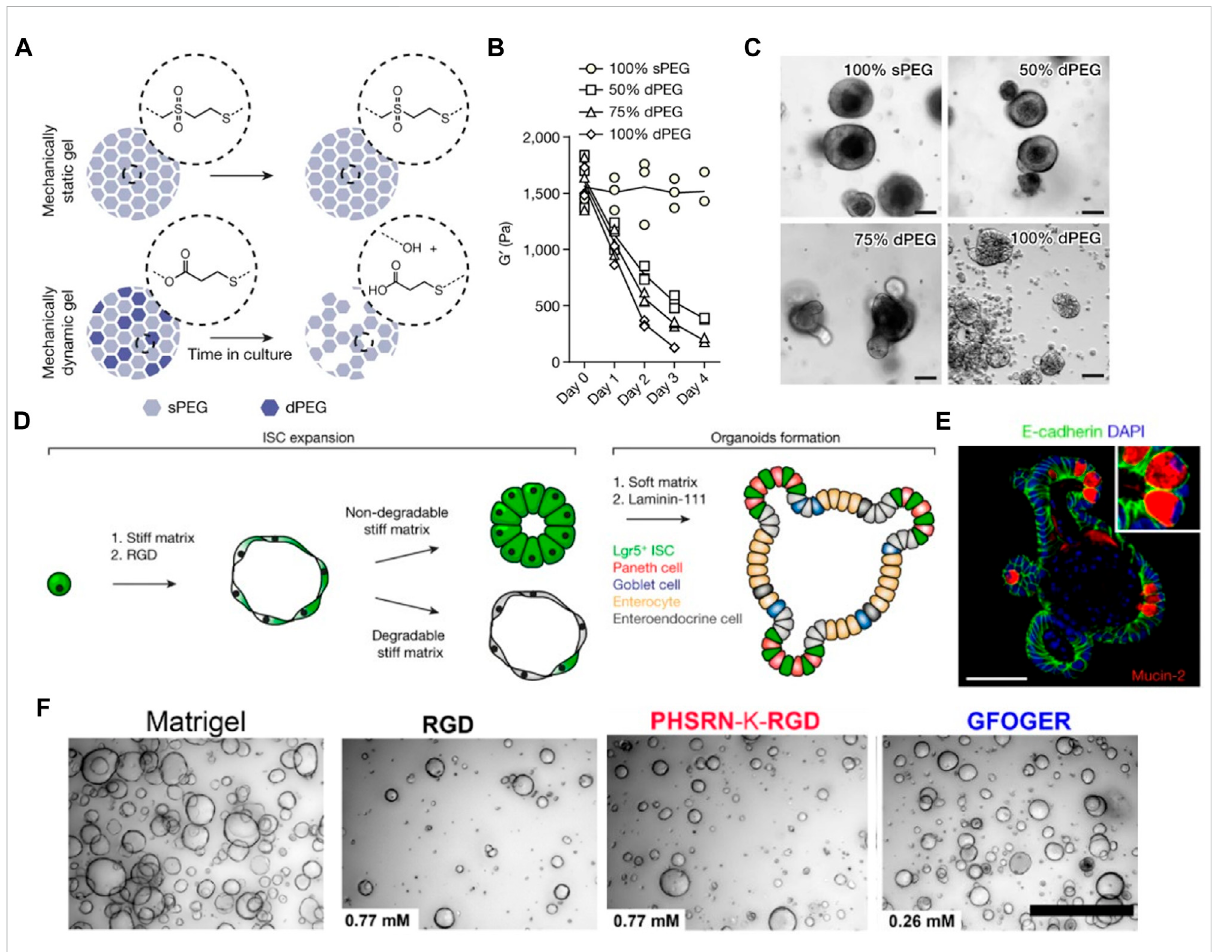
FIGURE 2 Intestinalorganoidformationwithinchemically-de fi nedengineeredPEGhydrogels. (A) SchematicillustrationofmechanicallydynamicPEGgel with hydrolytically degradable crosslinks for matrix softening. (B) Mechanical characterization of hybrid PEG gels. (C) Organoid formation of mouse ISCs grown in matrices of different softening rates. (D) Schematic showing different stages of intestinal organoid formation within the engineered PEG hydrogel. (E) Immuno fl uorescence staining of intestinal organoid containing differentiated intestinal cells. Adapted from ref. (Gjorevski et al., 2016). (F) Bright- fi eld images of the formation of human intestinal enteroids cultured in Matrigel and different PEG gels containing RGD, PHSRN-K-RGD, and GFOGER peptides. Adapted from ref. (Hernandez-Gordillo et al., 2020). Scale bars, (A,B,E) 50 µm and (F) 500